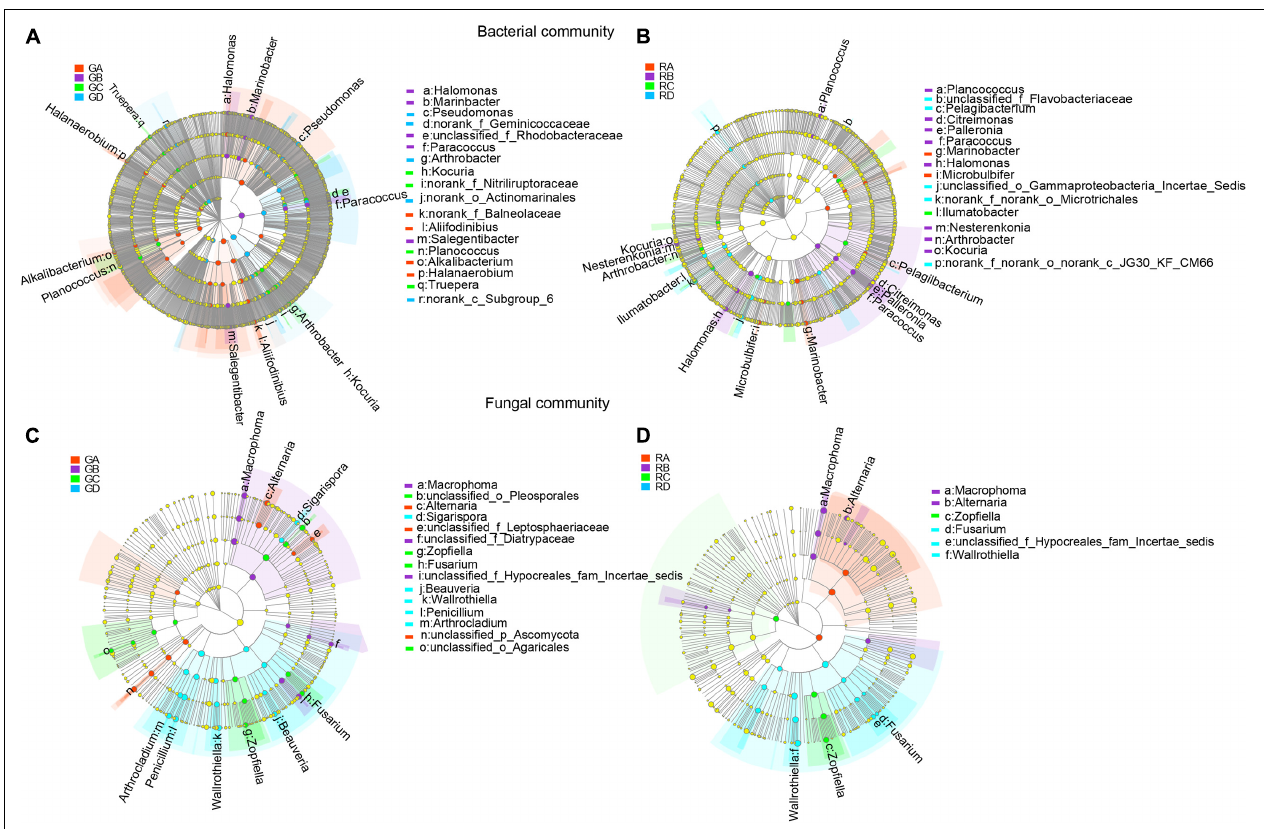
FIGURE 4 | The differential phylogenetic distribution of bacteria (A,B) and fungi (C,D) in Ejinur Salt Lake different rhizosphere soil and root endophytic samples. The linear discriminant analysis scores of > 4. The five rings of the cladogram stand for phylum (innermost), class, order, family, and genus. Different colored nodes represent microorganisms that play an important role in the grouping represented by color; yellow represents non-significant. Uppercase “G” represents the rhizospheric sample, and uppercase “R” represents the endophytic samples. S. europaea (A) , S. salsa (B) , P. communis (C) , and A. splendens (D)